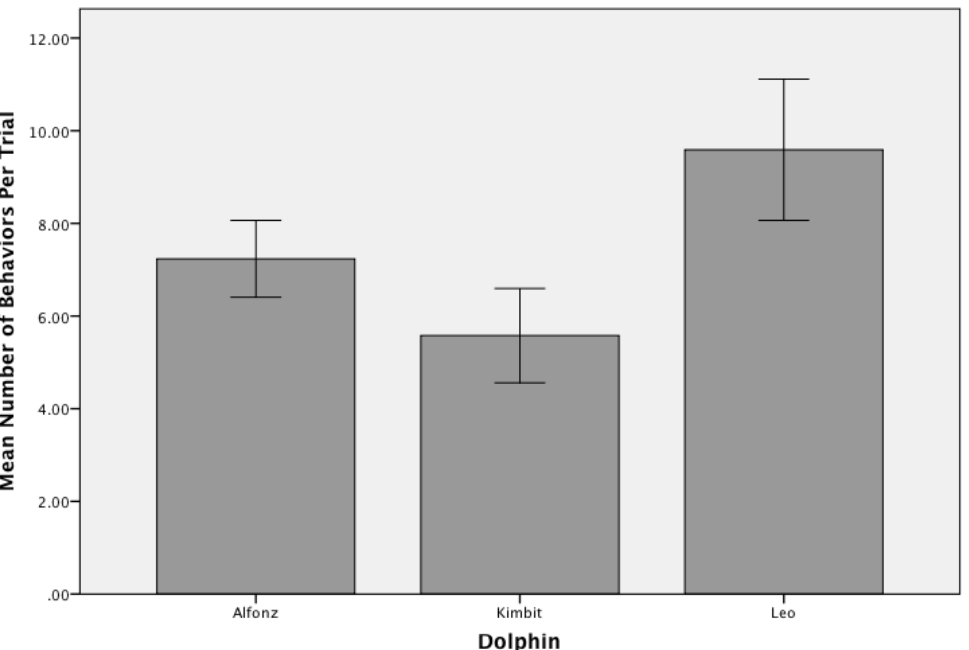
Figure 2 . Mean number of different behaviors per test trial for each